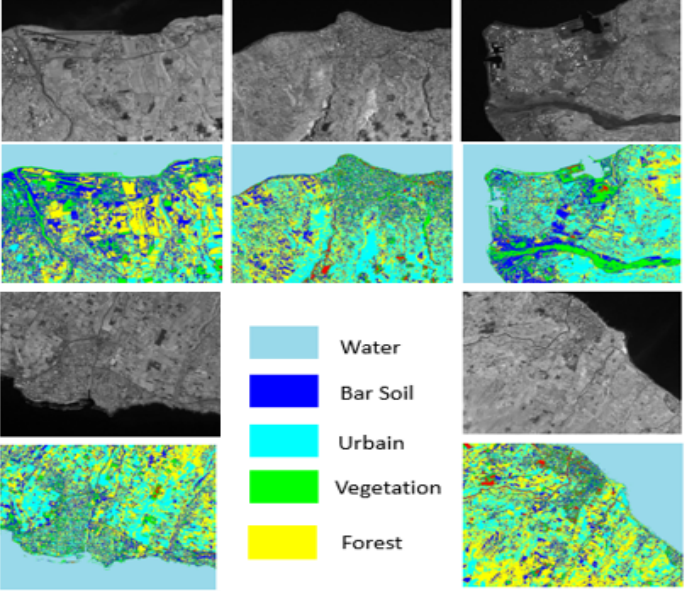
Figure 14. Remote sensing images on top are image ground truth, the images at the bottom are our results: the classified images and Some extracted classes.